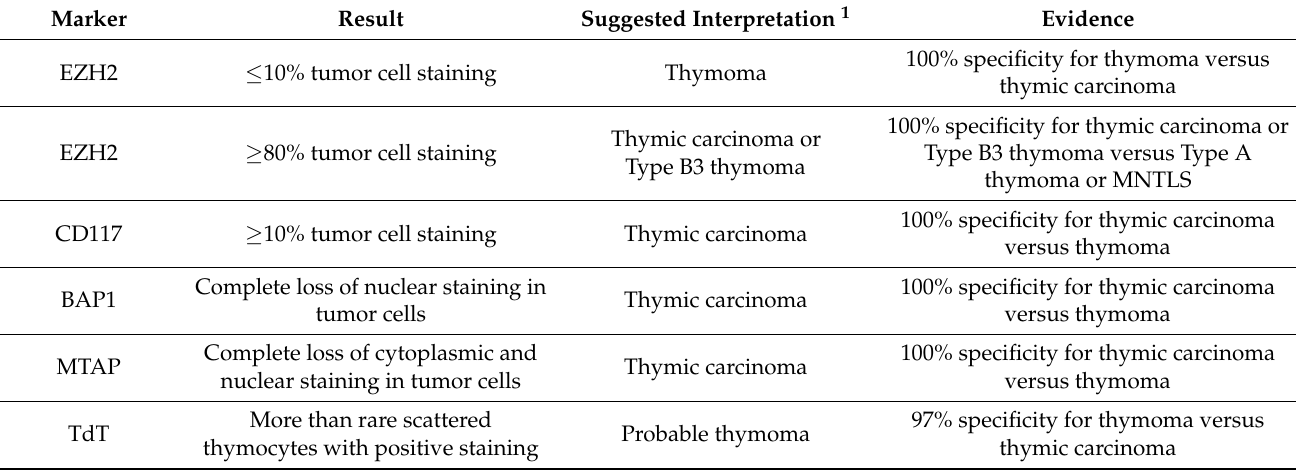
Table 4. Suggested interpretation of potentially informative results from the recommended